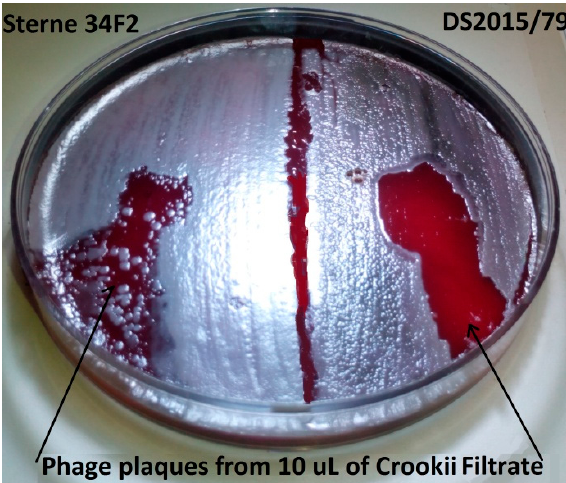
Figure 1. Blood agar plate with Bacillus anthracis bacterial lawns of Sterne 34F2 (left) and virulent DS201579 (right) after 12 h incubation at 37 °C. The plaques indicated by the arrows are where the bacteriophage Bacillus phage Crookii has lysed bacterial cells. The phage demonstrates a greater affinity for B. anthracis DS201579 than Sterne strain; where the DS201579 lawn is also displaying turbidity indicating phage infection.